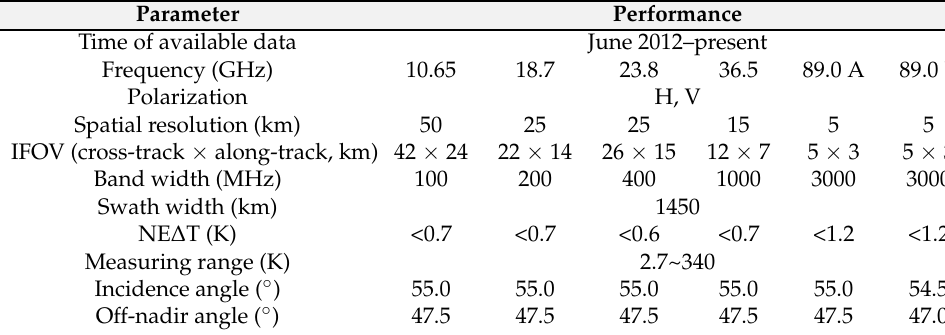
Table 2. Major performances and characteristics of the AMSR-2 sensors.